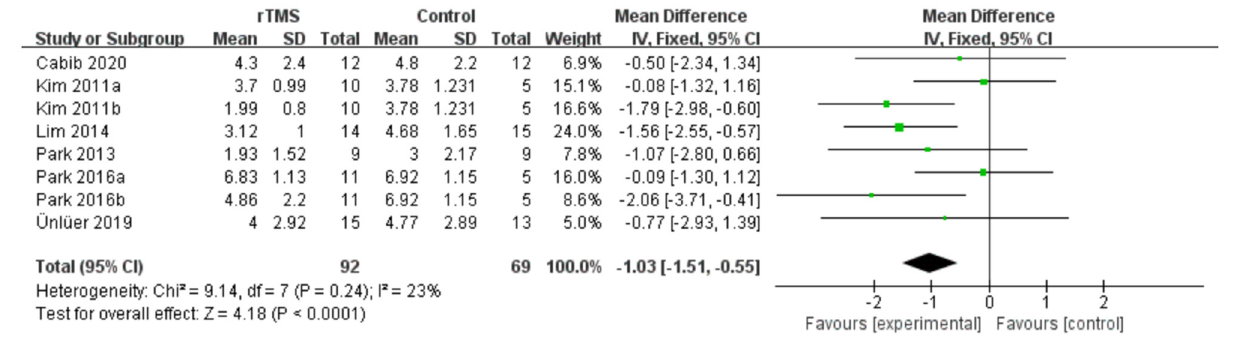
FIGURE 7 | Forest plot for subgroup analysis for Penetration Aspiration Scale.